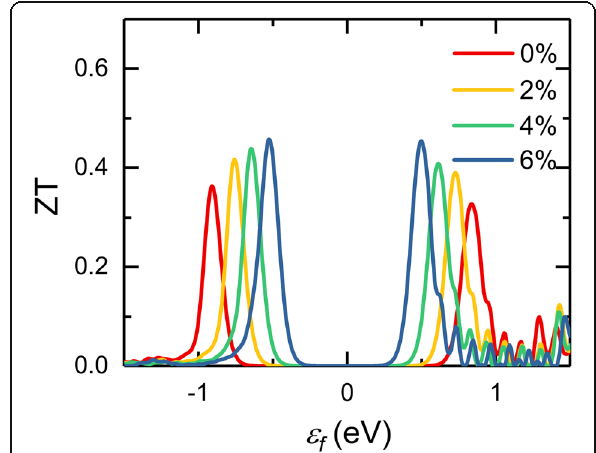
Fig. 6 Calculated figure of merit of monolayer InSe as a function of chemical potential under different